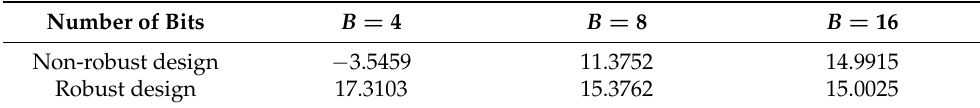
Figure 4. SNIR of the worst user within each group of K users (averaged over different channel realizations). The target SNIR is 15 dB. Table 1. Real SNIR (dB) of the worst user within each feasible group (averaged over different channel